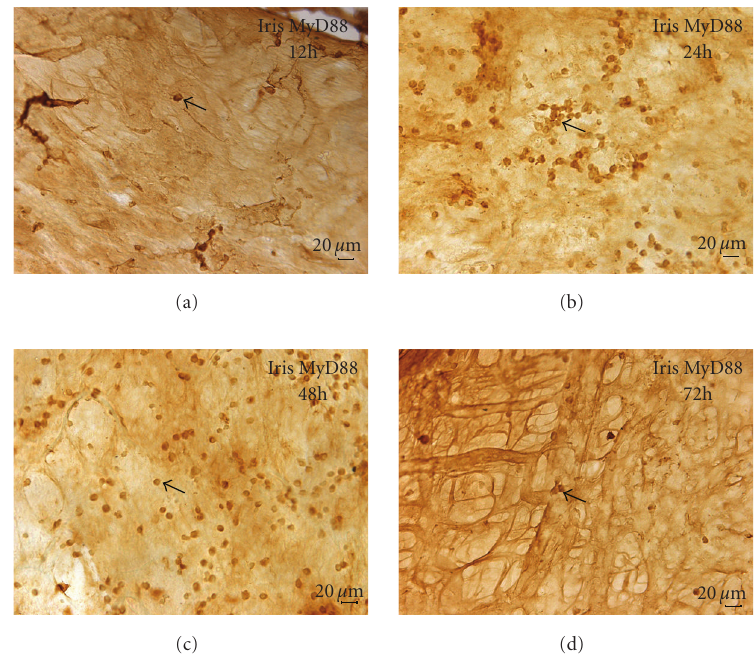
Figure 5: Immunohistochemistry of MyD88 (DAB): (a) The MyD88 positive cells were shown at 12 h. (b) Most of MyD88 expressed in the iris at 24h. (c) The immunopositive cells were predominantly round-ovoid cells at 48h. (d) MyD88 positive cells had been decreased in the iris at 72 h (Bar = 20 μ m).